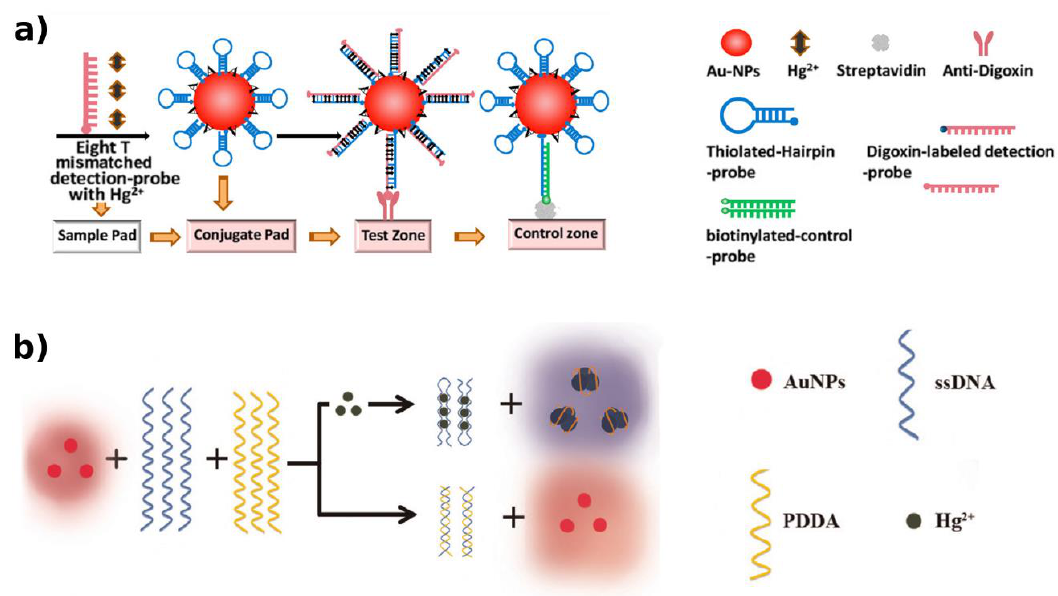
Figure 6. T–Hg 2 + –T structure and hairpin probe-modified AuNPs-based strategy for colorimetry- based HM detection. ( a ) The digoxin dsDNA–AuNPs complexes are captured by immunoreaction with the anti-digoxin Ab* immobilized on the strip and revealed by a red band [98]. ( b ) With the formation of the T–Hg 2 + –T, a random coil-to-hairpin structure change occurs, avoiding ssDNA interaction with PDDA. A color change is observed due to the AuNP aggregation by free PDDA [89]. Adapted with the permission of the Publishers.